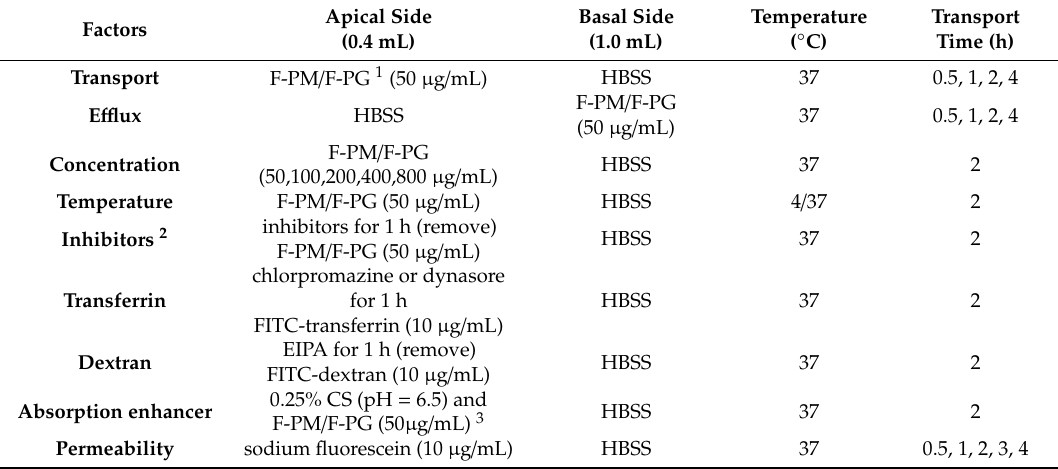
Table 1. E ff ects of various factors on the transport of samples. EIPA, 5-( N -ethyl- N -isopropyl) amiloride. Factors